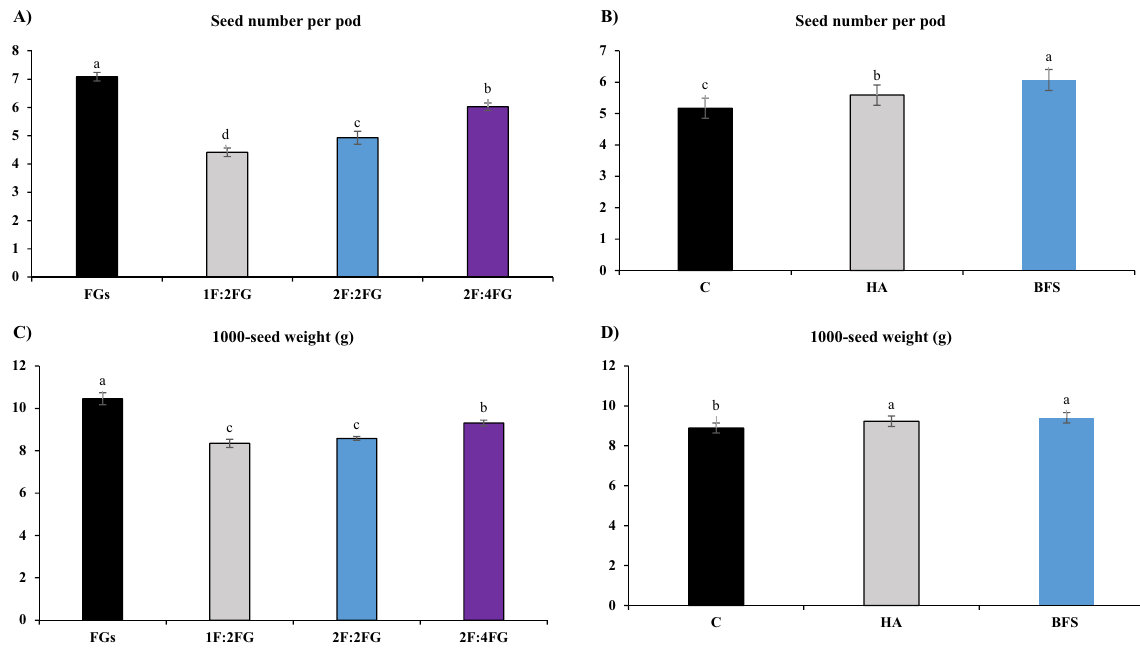
Figure 5. Means comparison for the main effects of cropping patterns [FGs (fenugreek sole cropping), 1F:2FG, 2F:2FG, 2F:4FG (ratios of fennel and fenugreek in the intercropping patterns)] on seed number per pod ( A ) and 1000-seed weight ( C ), and fertilization [C (control), HA (humic acid), BFS (biofertilizers)] on seed number per pod ( B ) and 1000-seed weight ( D ) of fennel. Different lower-case letters above the bars indicate significant (p ≤ 0.05) differences.